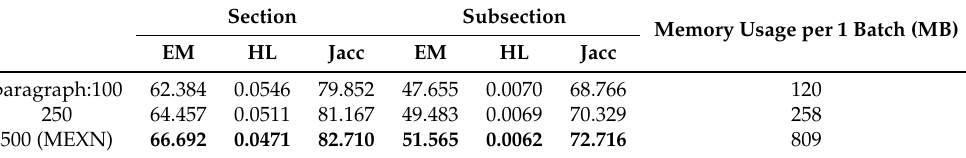
Table 6. Comparisons on the paragraph length.